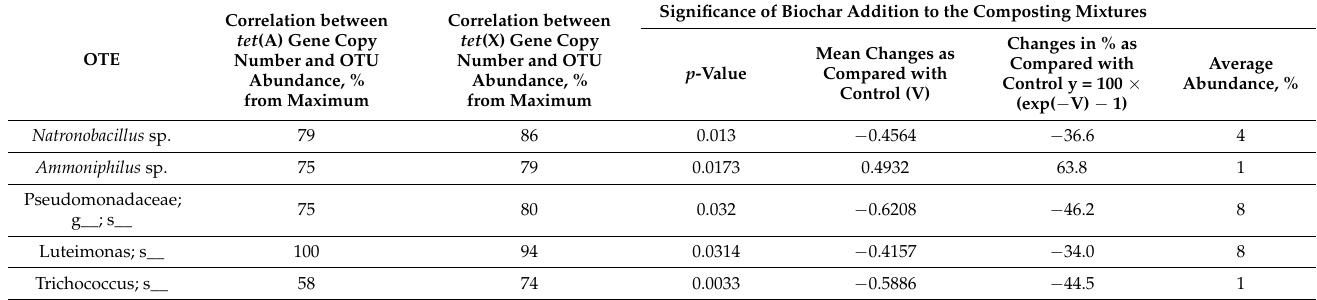
Table 3. Correlation between tet (A) and tet (X) gene copy numbers and OTU abundance levels and the significance of the biochar addition to the composting mixtures (fragment). The entire table is presented in Supplementary Table